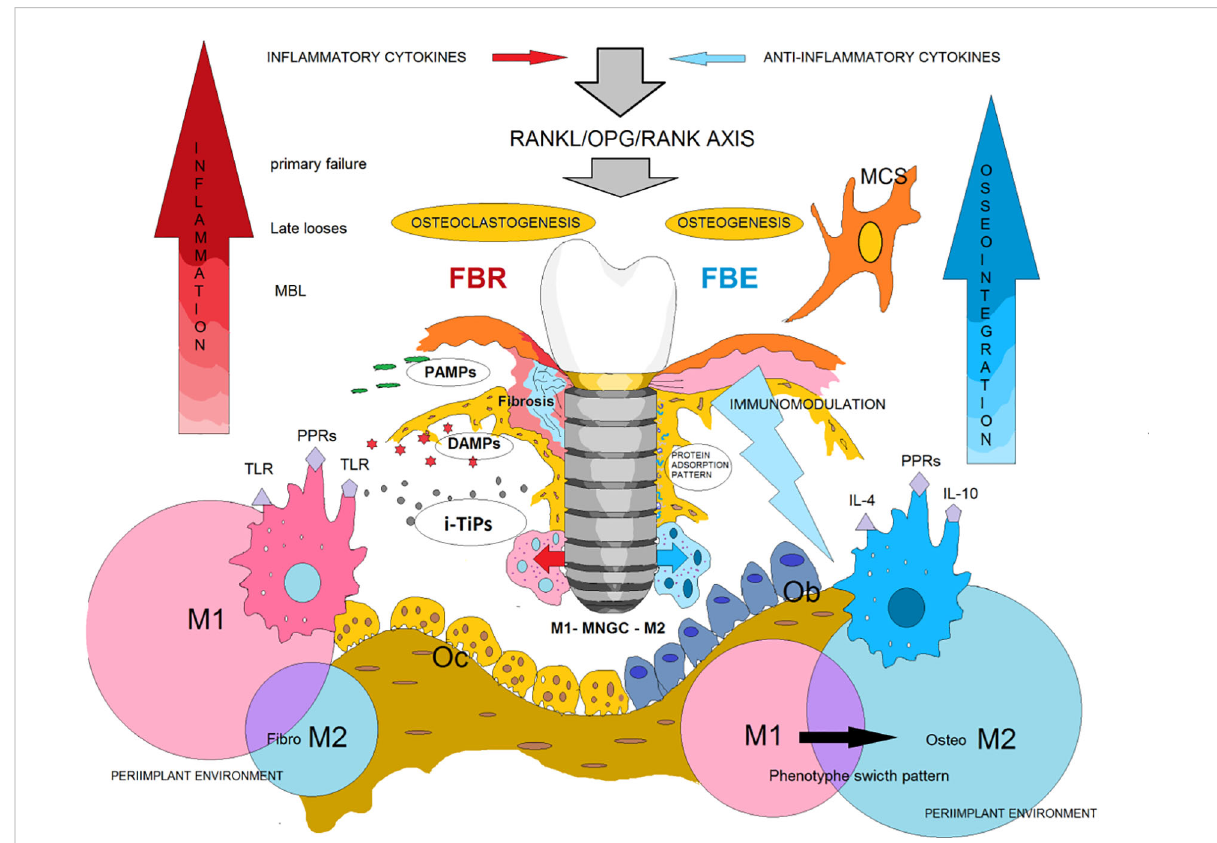
FIGURE 4 Implant-Osteoimmune interaction. Osseointegration is a condition of continuous and dynamic implant-osteoimmune interaction. If the implant surface evokes an initial and long-term immunomodulation, interfacial bone is formed to shield off the implant from the tissues (FBE). In addition, the M2 anti-in fl ammatory environment would induce adequate defense reactions to handle transient septic and aseptic threats (PAMPs, DAMPs, Implant-derived Titanium particles (i-TiPs) ), which is clinically re fl ected with 10 year failure rates varying between 0-4%. However, if it is continuous and of considerable size, the provocation and the consequent M1 in fl ammatory environment can generate In fl ammatory cytokines that alters the expression of RANK/RANKL axis, counteracting the ability of implant surface osteoimmunomodulation, then a partial, progressive or total FBR can occur. Modi fi ed from Zetao Cheng, et al